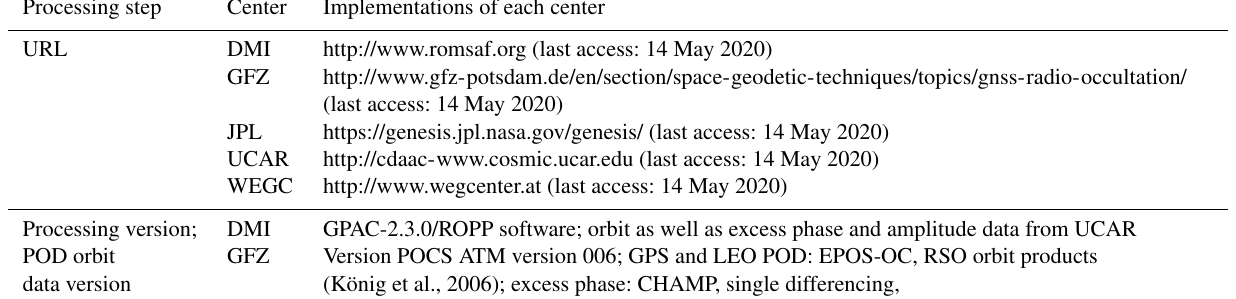
Table 1. Overview of processing steps for RO dry and moist air retrieval at DMI, GFZ, JPL, UCAR, and WEGC. Processing